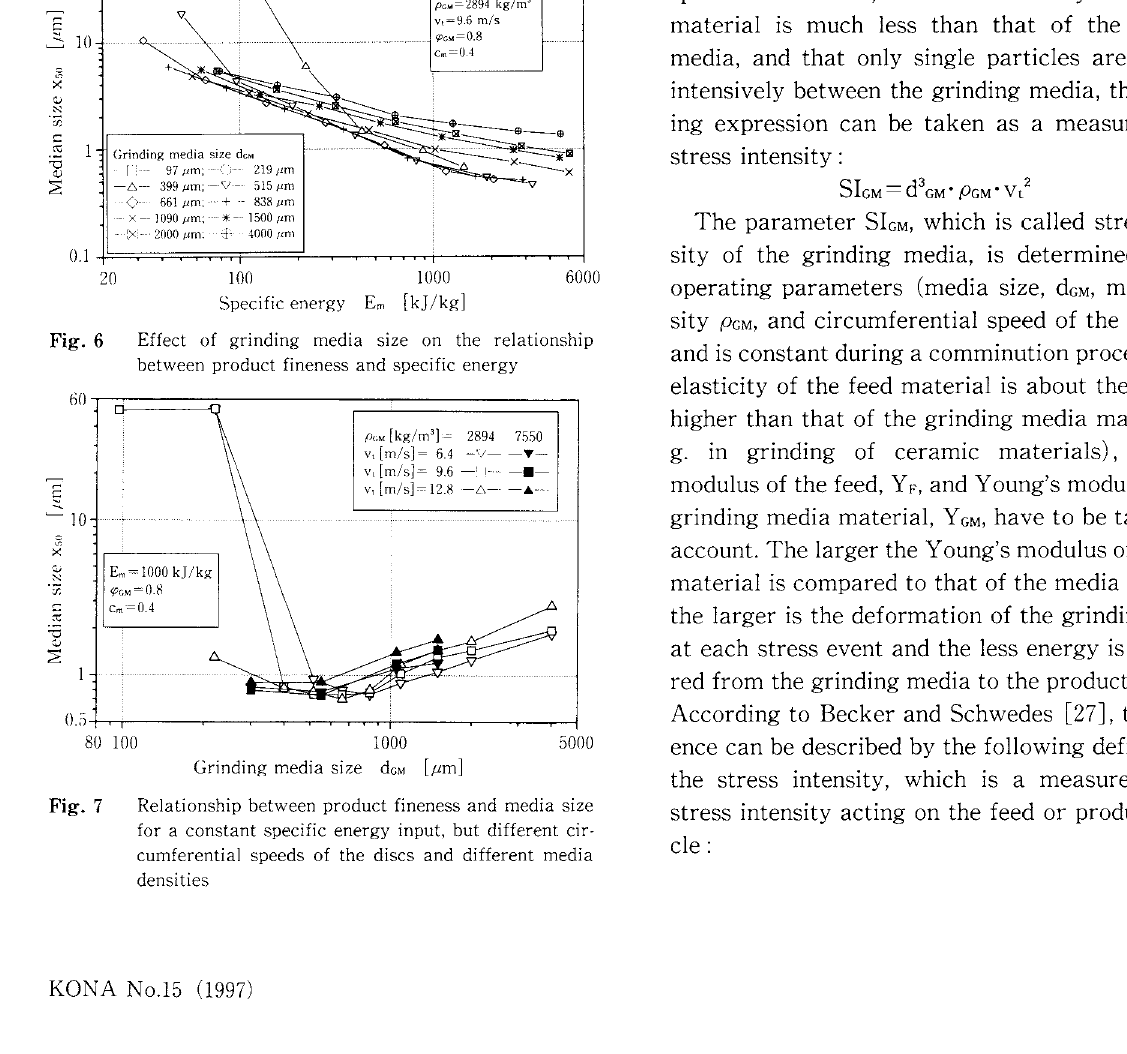
Relationship between product fineness and media size for a constant specific energy input, but different cir cumferential speeds of the discs and different media